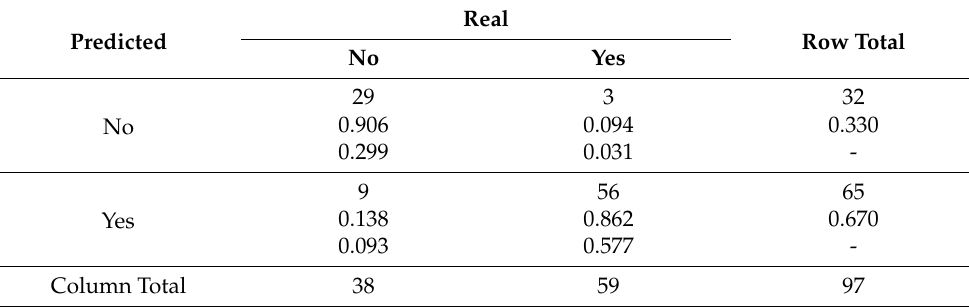
Table 3. Confusion matrix. Radial Basis Neural Network